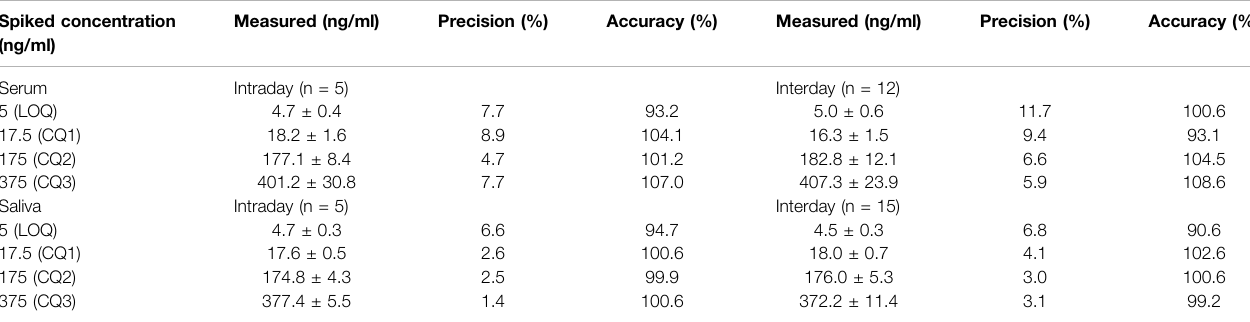
TABLE 3 | Intraday and interday precision and accuracy of 7-hydroxy-CBD in human serum and saliva. Spiked concentration